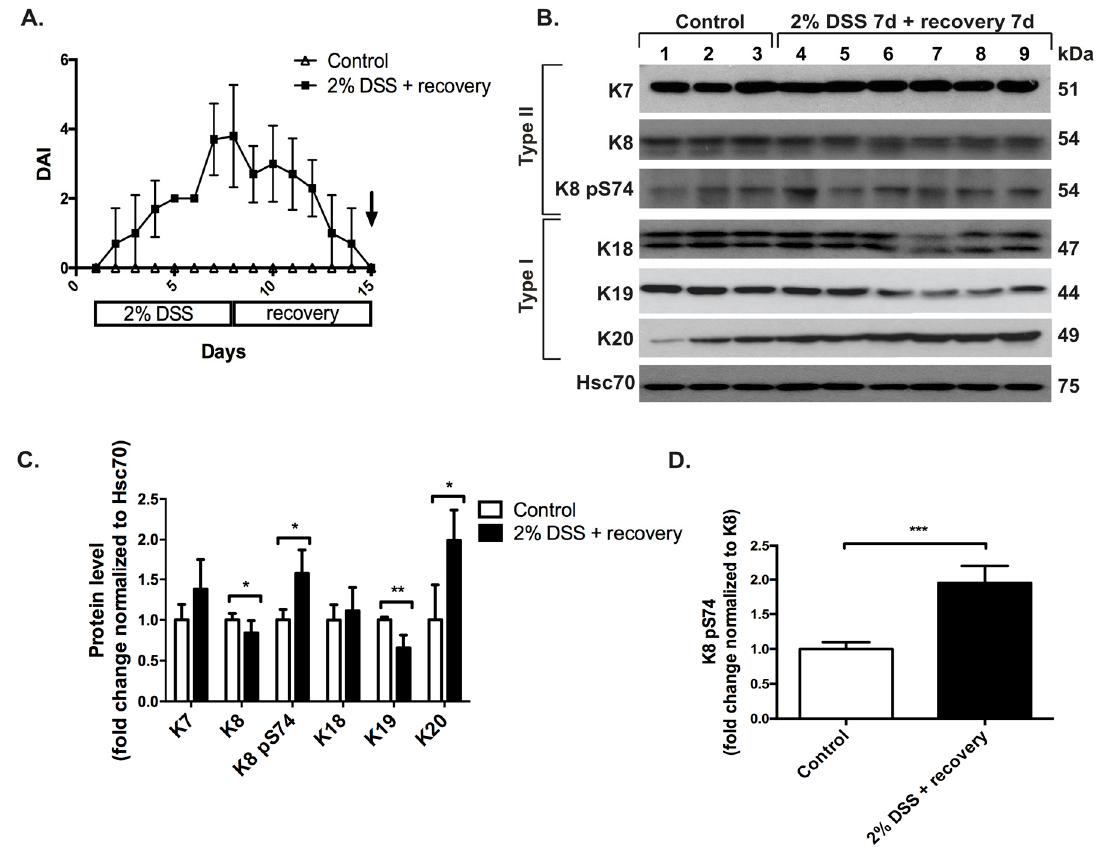
Figure 2. Acute DSS-associated keratin level alterations are not normalized after 7 days of recovery from DSS colitis even if the colon DAI is normalized. Mice ( n = 3 for controls, lanes 1–3 in B, n = 6 for DSS, lanes 4–9 in B; strain Balb/c) were treated with 2% DSS for 7 days followed by 7 days of recovery time, after which samples were collected for protein and immunofluorescence analysis. ( A ) The daily DAI was calculated on the basis of body weight loss, stool consistency and presence of blood in stool during the whole experimental time of 14 days in order to monitor progression of colitis and recovery. The arrow indicates time point of sacrifice and sample collection. ( B , C ) A downregulation of the major keratin pair K8 and K19, together with upregulation of K20 and slight increase in K7, was seen when analyzed by Western blotting as described in Figure 1. * p < 0.05, ** p < 0.01. ( D ) K8 pS74 levels were normalized to K8 protein levels. Despite of the downregulation of K8, an increase in K8 pS74 was seen. *** p < 0.001. Numerical data are shown as average ± SD. Statistical significance for Western blot data was determined by t-test.